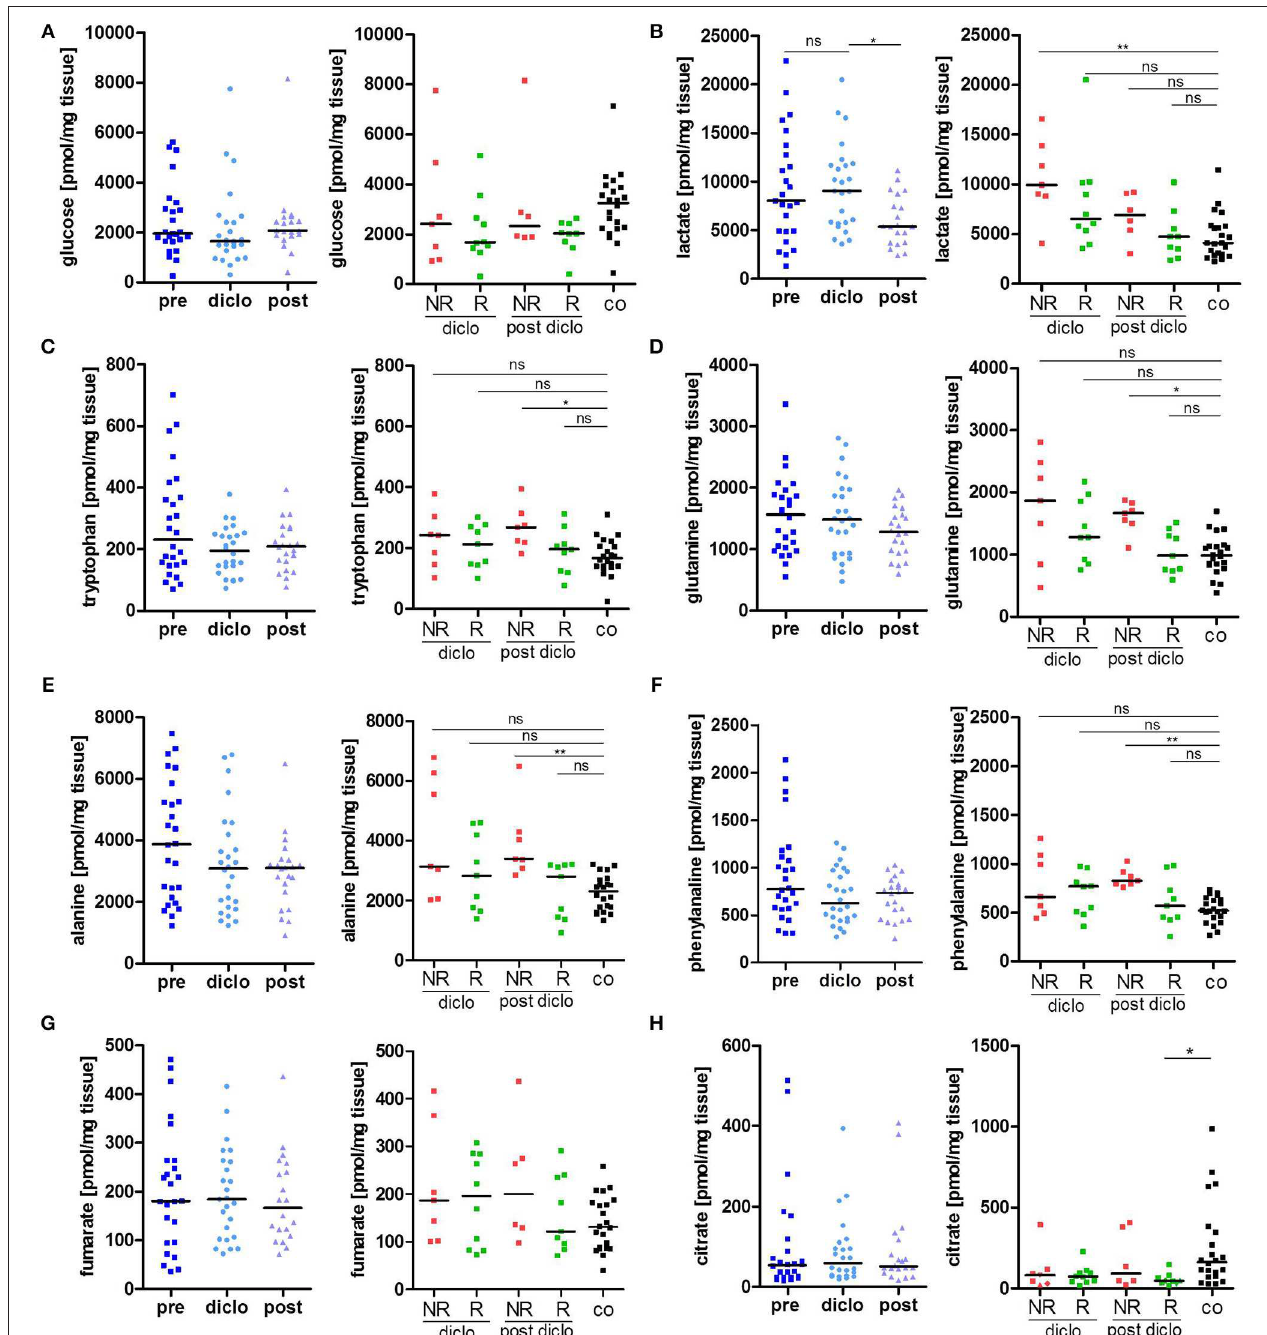
FIGURE 2 | Metabolic response to diclofenac in AK lesions. (A–H) Temporal changes in intratumor metabolite levels of (A) glucose, (B) lactate, (C) tryptophan, (D) glutamine, (E) alanine, (F) phenylalanine, (G) fumarate, and (H) citrate, in actinic keratosis lesions and control skin biopsies. Left graphs show all patients pre, on (diclo), and post treatment with diclofenac. Right graphs show non-responders (NR, n = 8) and responders (R, n = 12) to diclofenac on (diclo) and post treatment compared to controls (co). The dark lines indicate the median. * p < 0.05, ** p < 0.01 (Kruskal-Wallis test).